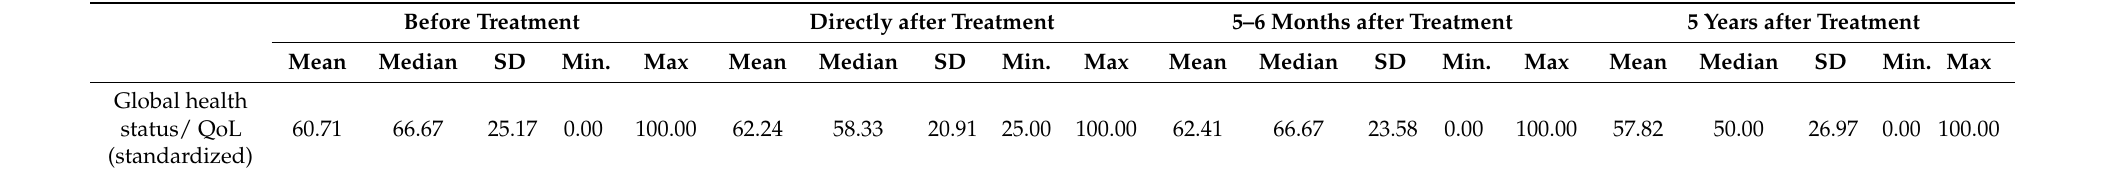
Table 4. Overall health and quality of life assessment by the